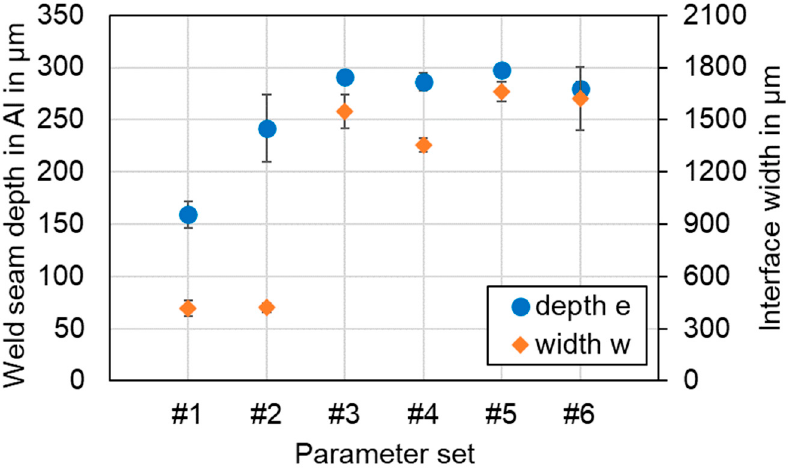
Figure 12. Weld seam depth in aluminum and interface width for selected parameter sets ( n = 4).